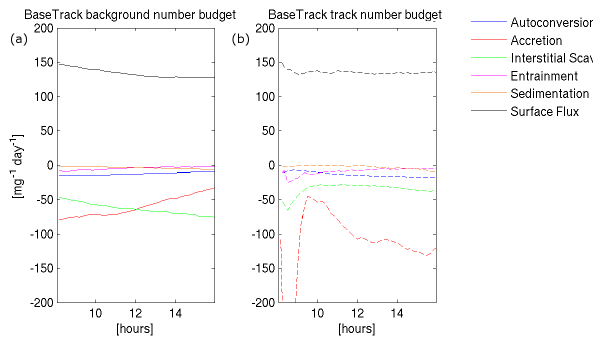
Figure 10. Regional aerosol budgets for run BaseTrack. (a) Time series of budget term magnitude in the background (solid) and (b) within the ship track